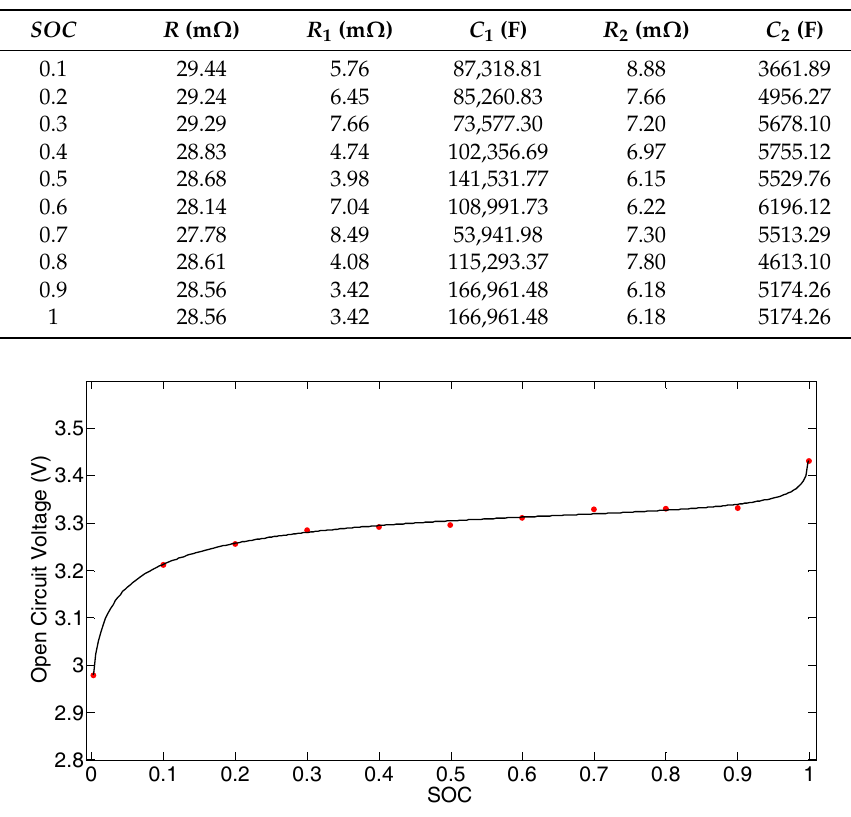
Figure 5. Open-circuit voltage (OCV) state-of-charge (SOC) curve.